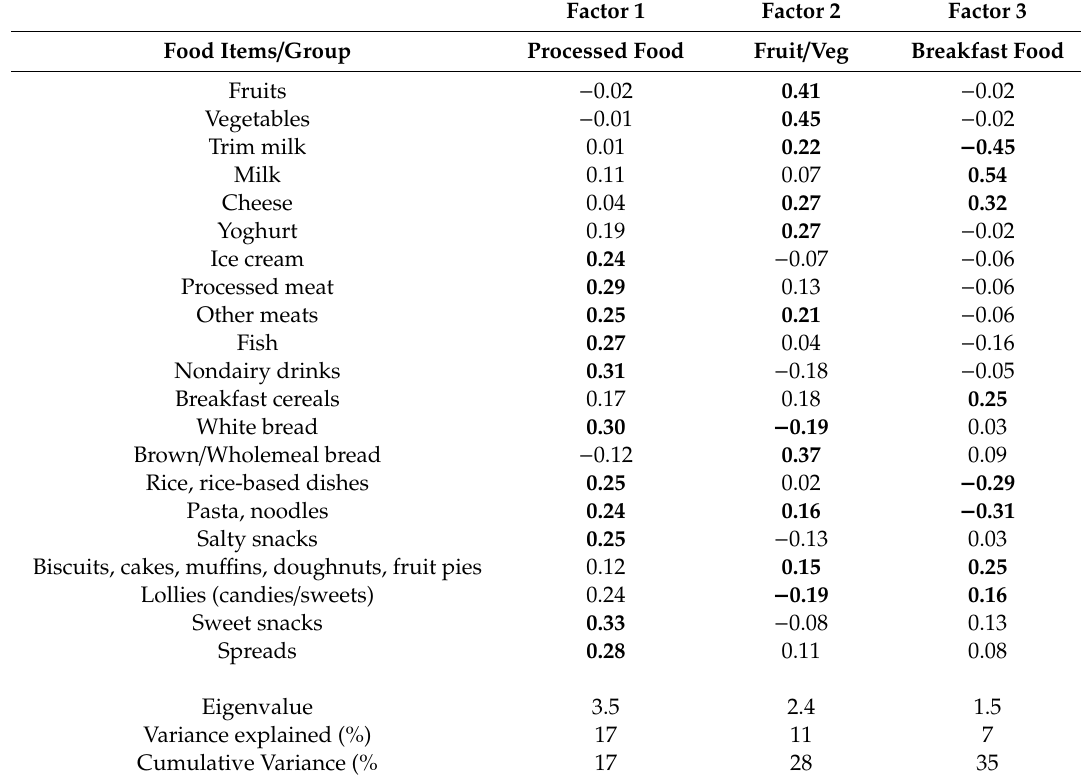
Table 2. Food type factor correlations ( n =